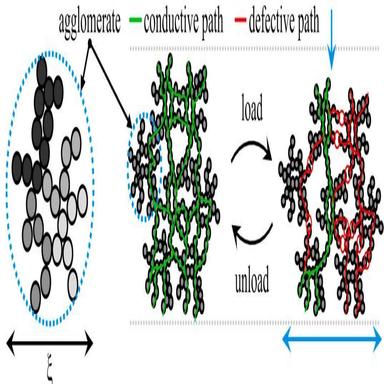
Structure of a carbon black network with a fractal filler cluster of size ξ. Virgin filler agglomerate is presented on the left. The circles represent primary carbon black aggregates. In the middle, conductive paths within the carbon black network are shown in green. On the right, paths that are defective due to mechanical loading are shown in red. (For interpretation of the references to colour in this figure legend, the reader is referred to the Web version of this article.)